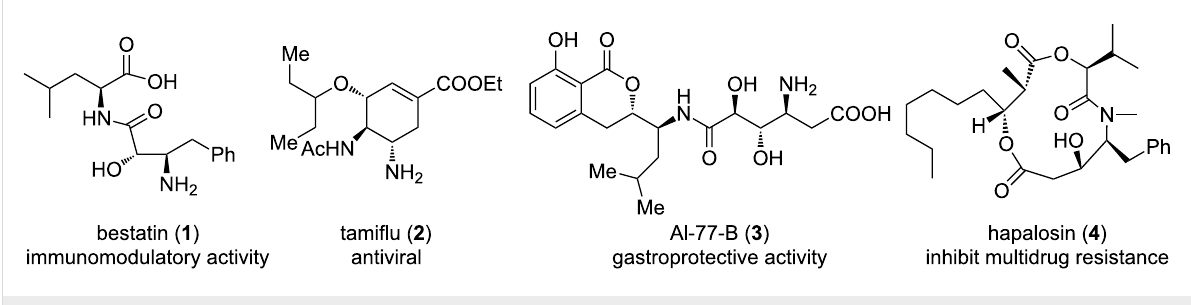
Figure 1: Bioactive compounds containing 1,2-aminoalcohol motif.